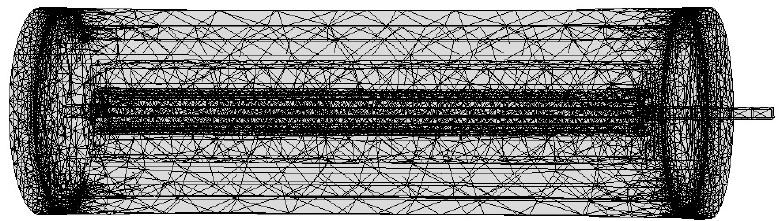
Figure 4. Meshing of a giant magnetostrictive actuator.